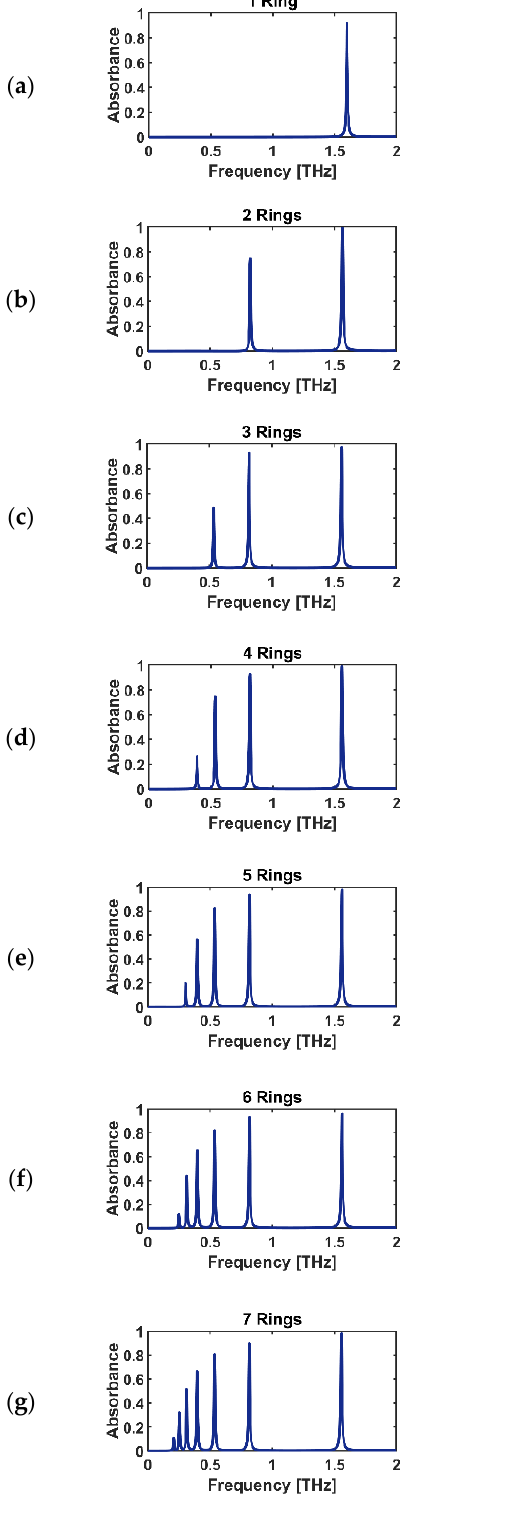
Figure 5. The left-side column shows the absorbance spectra (in blue); the middle column shows reflectance (in yellow) and transmittance (in red) spectra; and the right-side column shows the 3D illumination of the unit cell: ( a ) A with one RR antenna, ( b ) B with two, ( c ) C with three, ( d ) D with four, ( e ) E with five, ( f ) F with six, and ( g ) G with seven RR antennas.